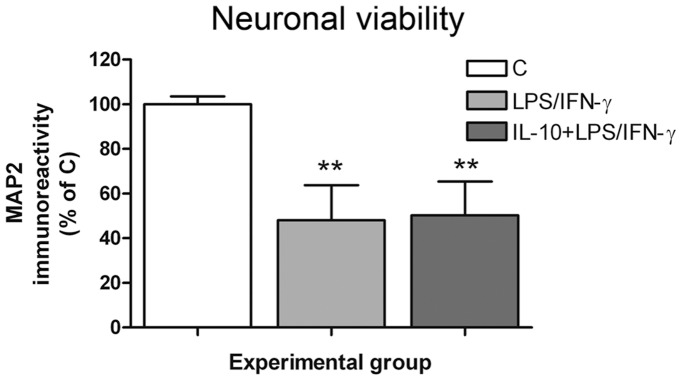
IL-10 pre-treatment did not inhibit the neurotoxicity induced by reactive microglia in neuron-primary microglia co-cultures.Neuron-primary microglia co-cultures were treated with 100 ng/mL LPS +30 ng/mL IFN-γ for 48 h in the presence or absence of 50 ng/mL of IL-10 administered 1 h prior to LPS/IFN-γ. Evaluation of neuronal viability by MAP2-ABTS-ELISA assay. Results are presented as % of MAP2 immunostaining in control co-cultures. Bars are means + SEM of four independent experiments. **p<0.01 vs control; one-way ANOVA (repeated measures) and Newman-Keuls post-test.